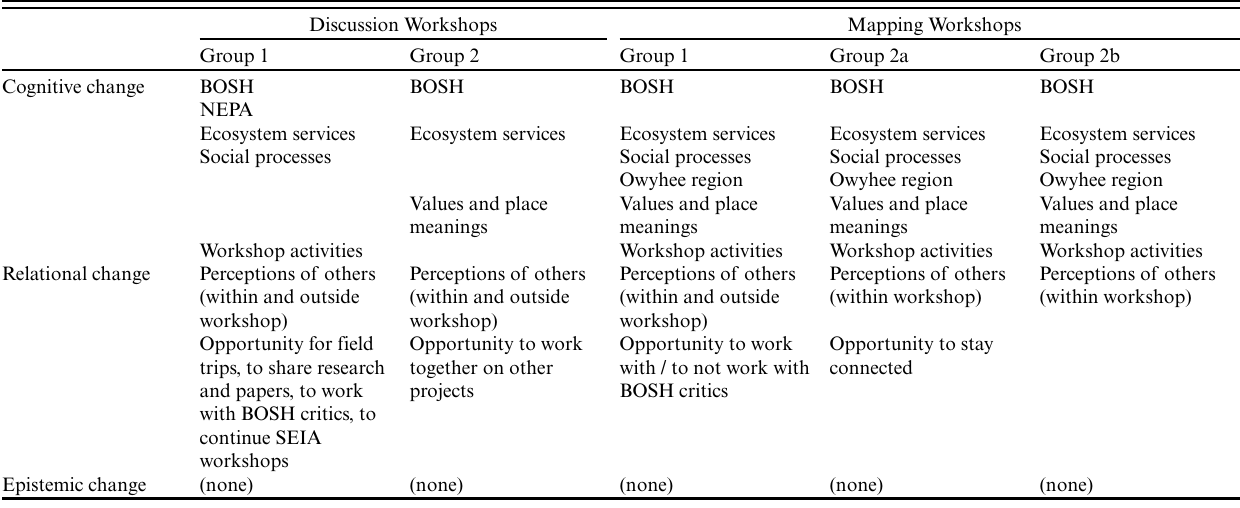
Table 3 . Topics of discussion during dialogic interactions that signaled opportunities for individuals’ cognitive and relational change. No opportunities for epistemic change were observed. BOSH = Bruneau-Owyhee Sage-Grouse Habitat Project; NEPA = National Environmental Policy Act; SEIA = social-ecological impact